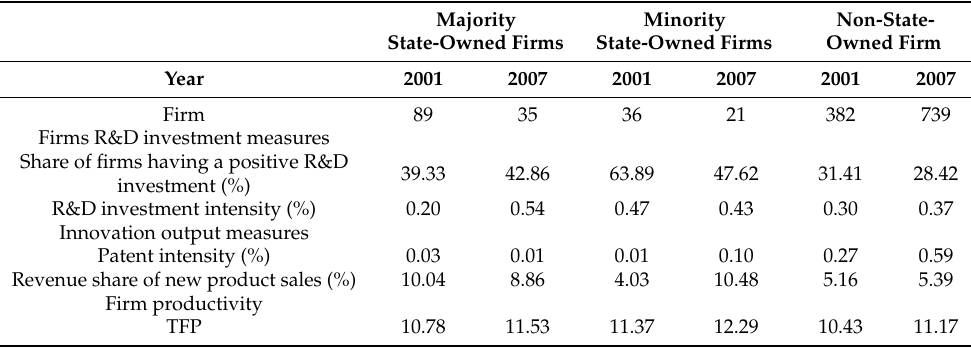
Table 5. Summary statistics of key variables among firms with different ownership.